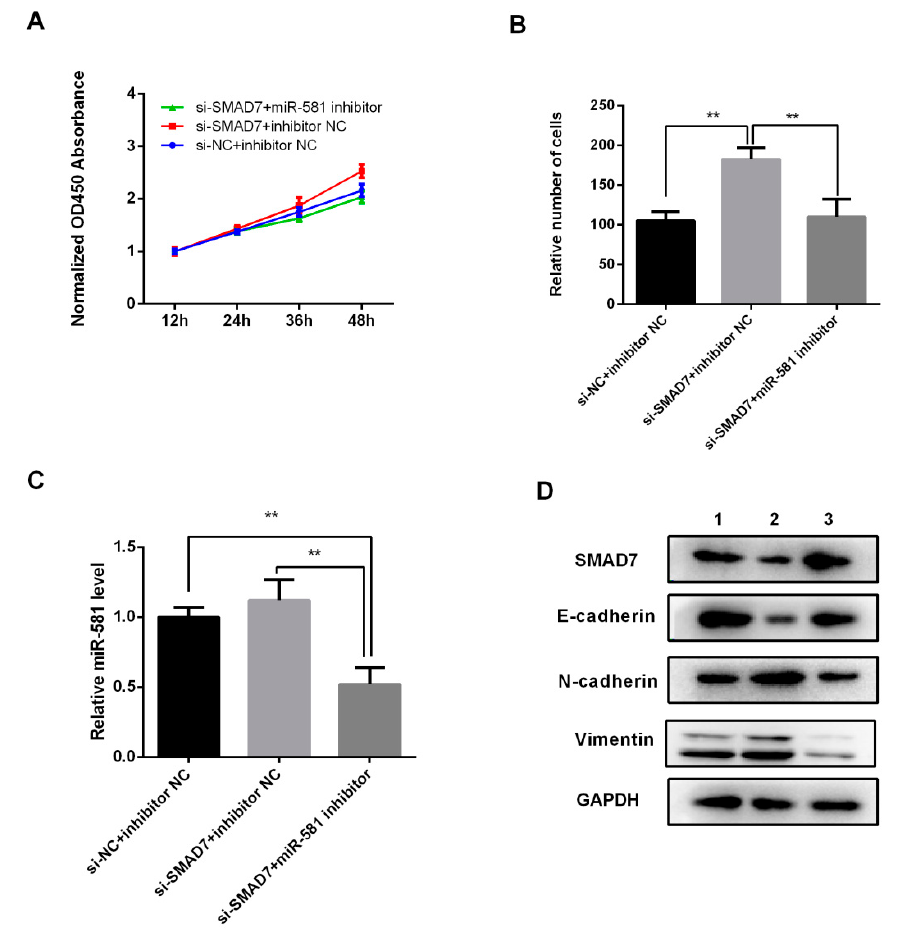
Figure 7. MiR-581 inhibition reversed the malignant phenotype induced by SMAD7 knockdown. ( A ) Cell proliferation was determined by CCK-8 assay. ( B ) Relative number of invaded cells in SMAD7 knockdown group, co = transfection group, and NC group. ( C ) miR-581 level was detected by qPCR. ( D ) EMT markers E-cadherin, N-cadherin, and Vimentin were detected by Western blot. Lane 1: si-NC + inhibitor NC; Lane 2: si-SMAD7 + inhibitor NC; Lane 3: si-SMAD7 + miR-581 inhibitor. ** p < 0.0 1.